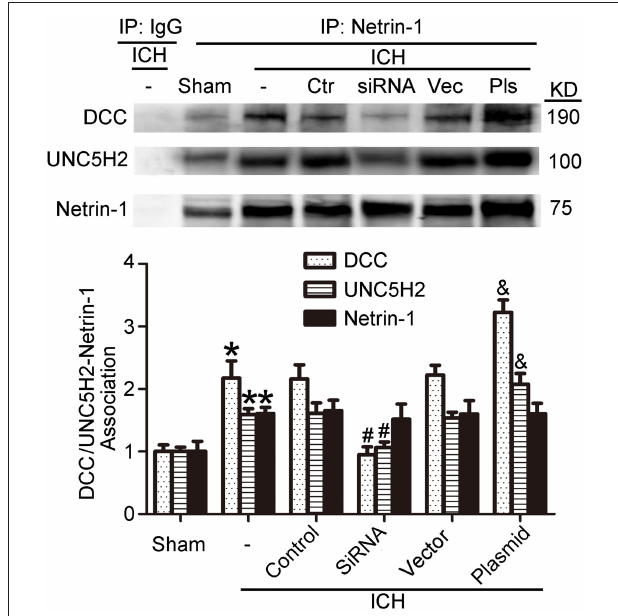
FIGURE 11 | Effects of KIF1A intervention on interactions between netrin-1 and DCC/ UNC5H2 . Netrin-1/DCC and netrin-1/UNC5H2 interactions in the peri-hematoma cortex were assessed by a co-immunoprecipitation assay. All values are expressed as mean ± SEM. Mean values of protein levels in the sham group were normalized to 1.0. * p < 0.05 vs. the sham group, # p < 0.05 vs. the ICH + control siRNA group, & p < 0.05 vs. the ICH + vector group, n = 6.